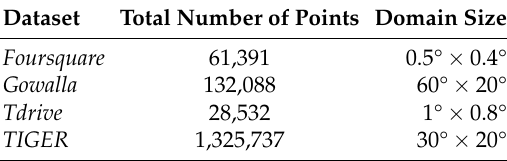
Table 1. Information about